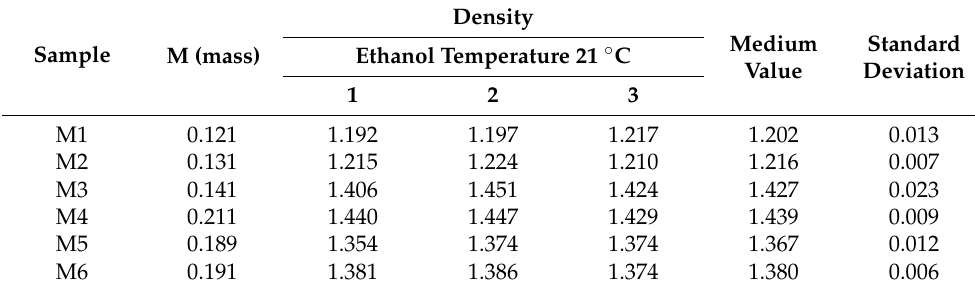
Table 1. The hydrostatic